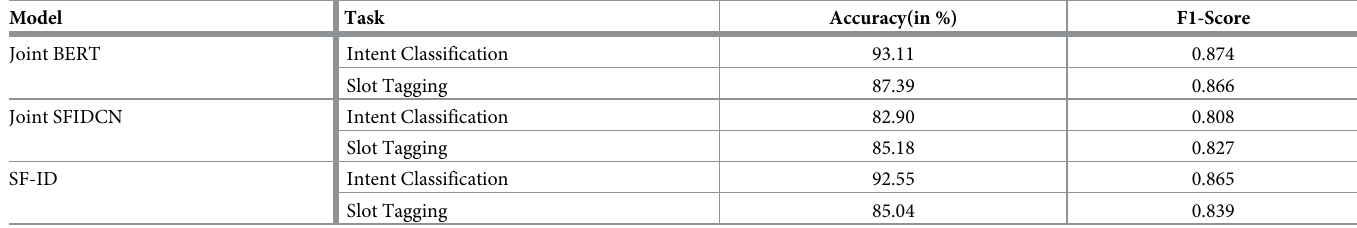
Table 5. Results for intent classification and slot tagging